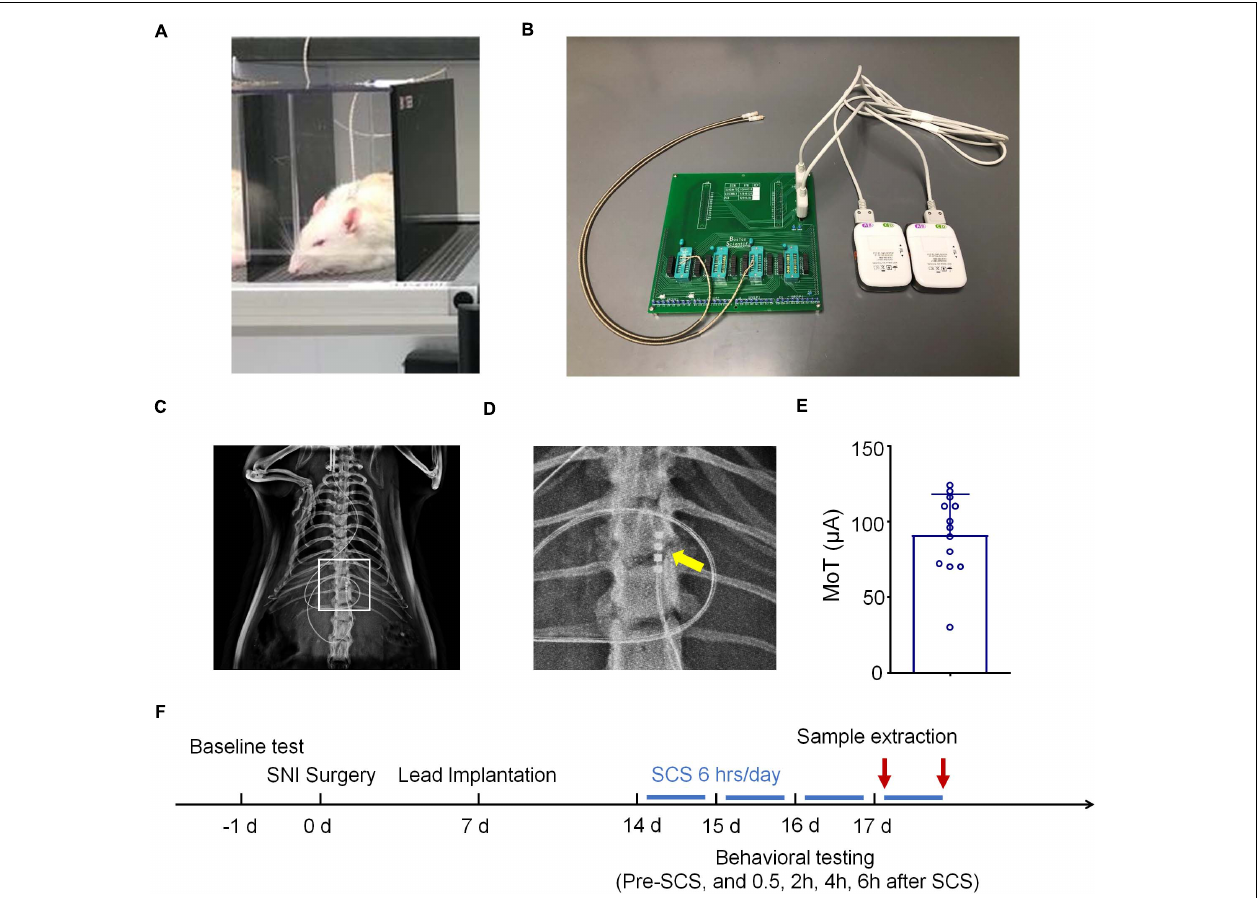
FIGURE 1 | Schematics for spinal cord stimulation (SCS) and experimental design. (A) Schematics for SCS and behavioral testing. (B) Images of SCS stimulator, which are connected to rats with electrodes. (C,D) Radiographs showing electrode implantation within the spinal column of rats. The box in C is enlarged in D with the electrode contacts indicated by an arrow. (E) Motor thresholds (MoT) of the rats used in this study, n = 13. (F) Experimental timeline of SNI surgery, electrode implantation, and